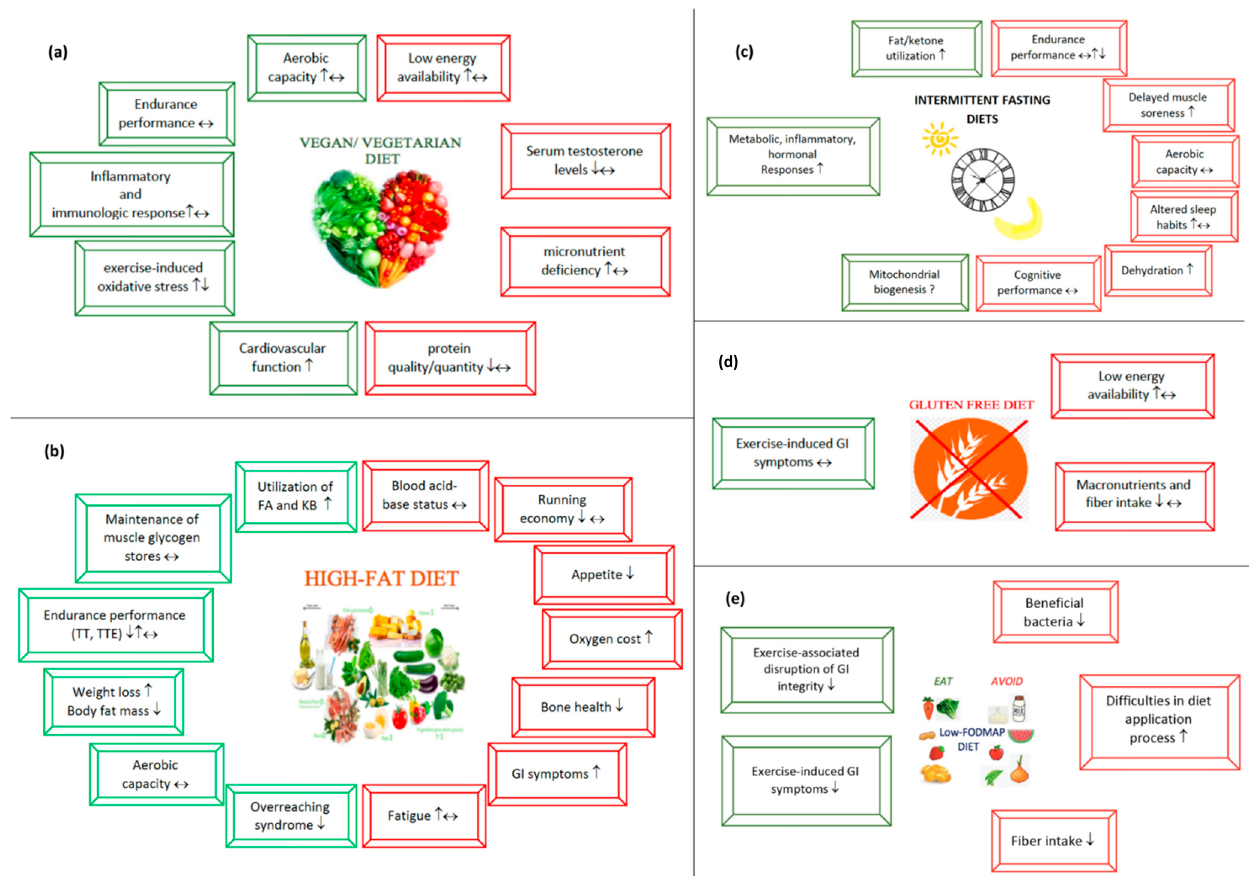
Figure 1. Possible beneficial and detrimental effects of popular diets on endurance athletes. Statements presented in green boxes show the beneficial effects of diets, while red boxes indicate the potential risks of diets. ( a ): Vegetarian diets; ( b ) high-fat diets; ( c ) Intermittent Fasting; ( d ) Gluten-free diet; ( e ) low-FODMAP diet. Abbreviations: URTI: Upper-respiratory tract infections; RED-S: relative energy deficiency syndrome; FA: fatty acids; KB: Ketone bodies; GI: Gastrointestinal; FODMAP: fermentable oligosaccharides, disaccharides, monosaccharides and polyols.